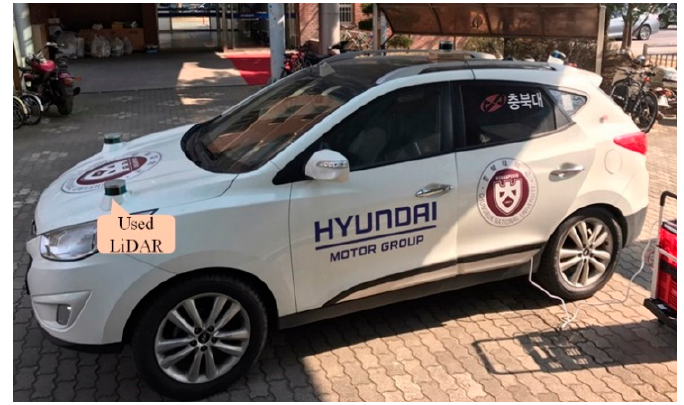
Figure 8. Configuration of a detection network.